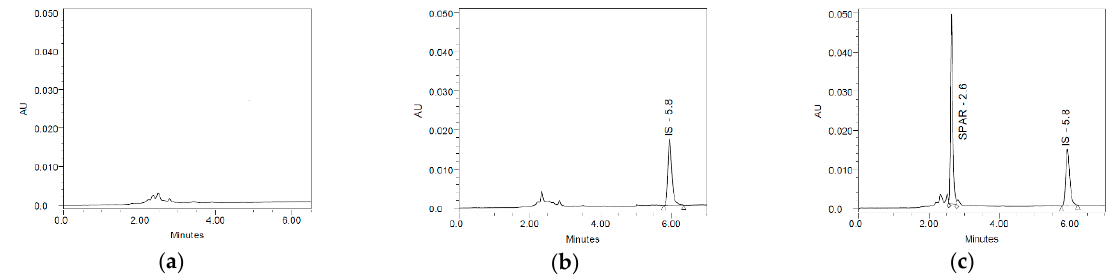
Figure 2. Representative HPLC chromatogram of: ( a ) blank plasma sample; ( b ) zero sample (IS, 2 µg/mL); ( c ) plasma sample fortified with SPAR (5 µg/mL) and IS (2 µg/mL).